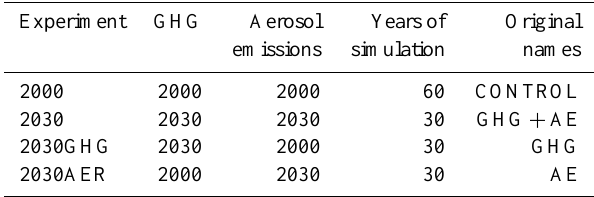
Table 1. ECHAM5-HAM experiment design and number of years simulated for each experiment. The original denomination used by Kloster et al. (2009) is shown in the last